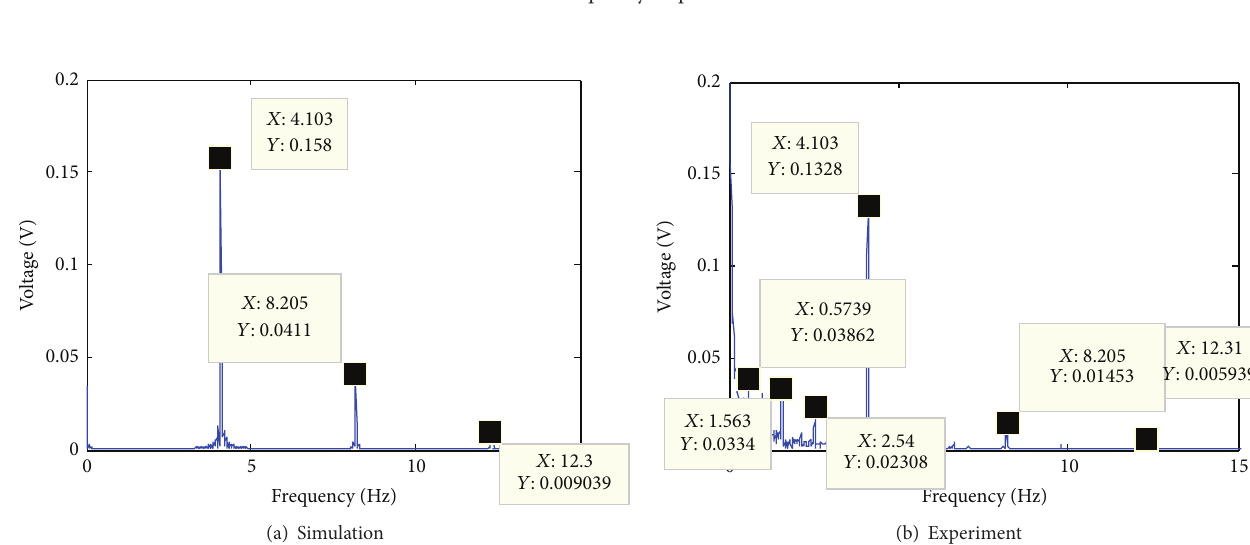
Figure 9: Frequency response at